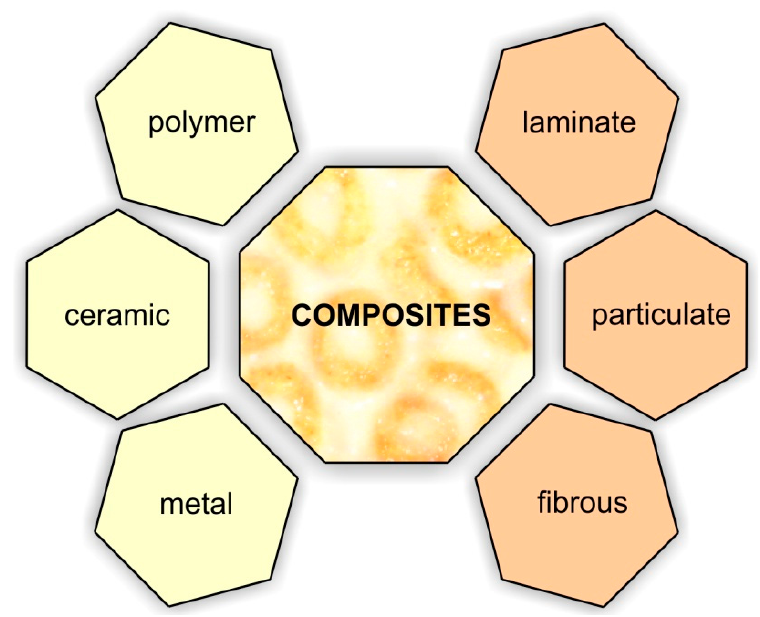
Figure 4. Classification of the composite materials.